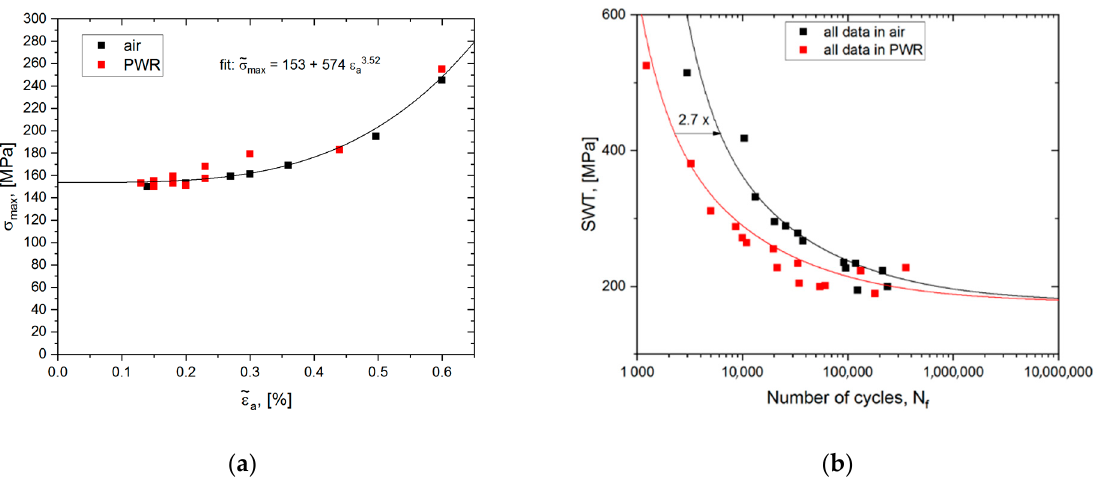
Figure 9. ( a ) Empirical relation between σ(cid:3557) (cid:2923)(cid:2911)(cid:2934) and ε(cid:3556) (cid:2911) ; ( b ) SWT–life curve calculated with NUREG-CR6909 mean curve coefficients.